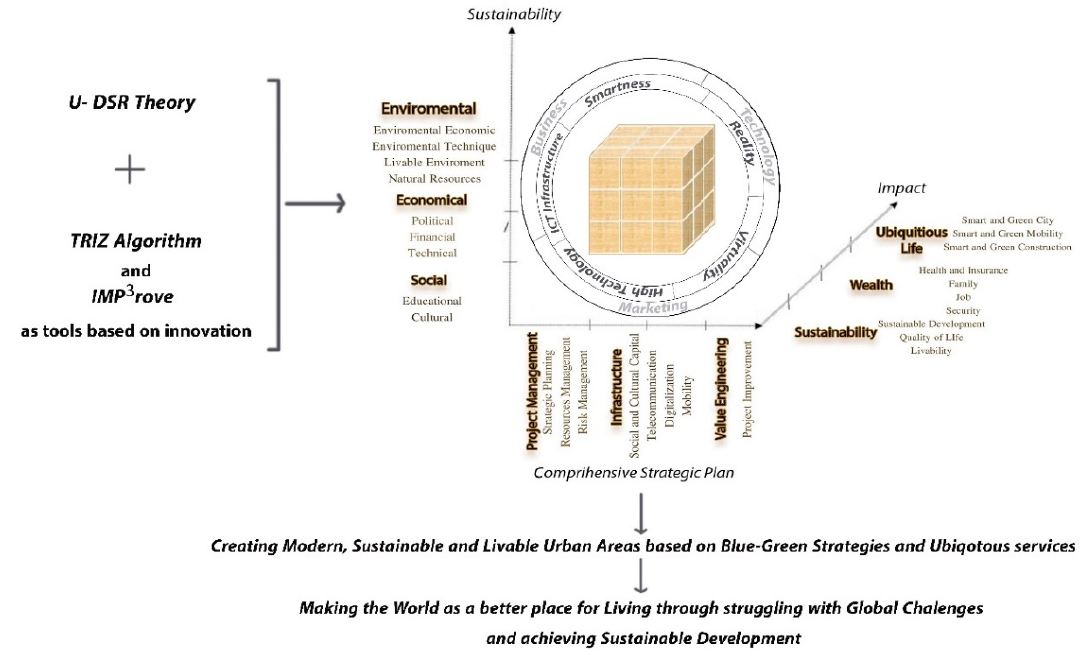
Figure 9. Towards more Sustainable and Livable World for Living (Authors).